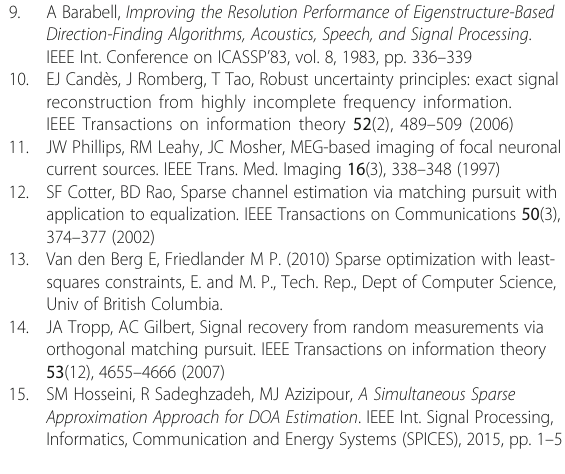
Fig. 10 Effect of number of sensors when the aperture size is fixed for the proposed